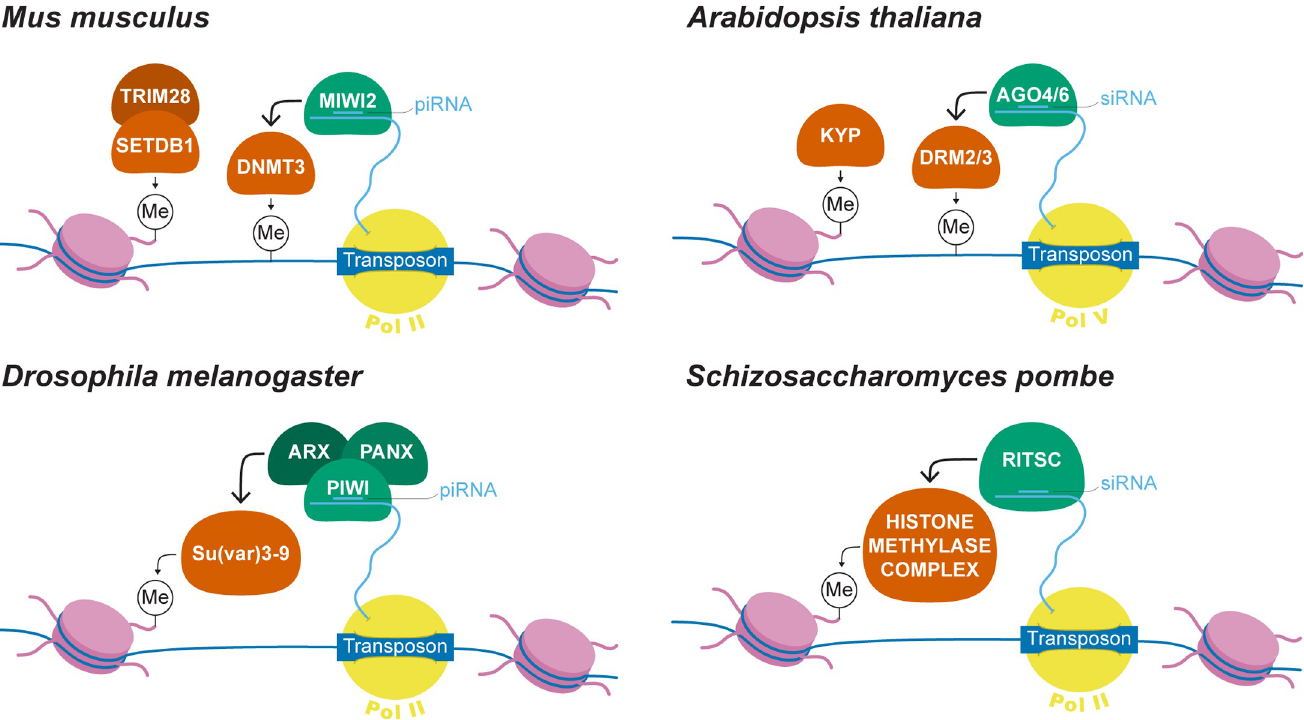
Fig 1. Mechanisms for the epigenetic silencing of TEs in animals and plants. To portray the similarities of the mechanism underlying TE epigenetic silencing between species, this figure only shows core proteins involved in the processes for four representative eukaryotic species. Detailed mechanisms and involved proteins could be found at other detailed reviews (e.g., [134,134–136]). In mammals, piRNAs are loaded onto MIWI2, which promotes a chromosomal environment that ultimately recruits the mammalian DNMT3 to methylate TE sequences [137,138]. Complementarily, KAP1, also called TRIM28, recognizes retroviral TE sequences by binding to a conserved primer binding site [139] and recruits H3K9 methyltransferase SETDB1 and HP1 to form a repressive heterochromatic environment at TE sequences [140–142]. Drosophila lacks DNA methylation, but TEs can still be epigenetically silenced through histone modifications. Nascent TE transcripts are targeted by piRNA loaded PIWI, which complexes with Asterix (Arx, also known as Gtsf1) and Panoramix (Panx, also called Silencio) [143–146]. This complex recruits Su(var)3-9, a key H3K9 methyltransferase, to lay down repressive H3K9me2/3 at TE sequences [147]. A similar mechanism is also observed in Schizosaccharomyces pombe, where RITSC binds to nascent TE transcripts through base-pairing with siRNAs and recruits histone methyltransferase complex to methylate H3K9 histone tails [148]. In plants, euchromatic TEs are silenced through the RdDM pathway [168]. AGO4 or AGO6 are guided by siRNA [149,150]and targeted to siRNA-matching regions through scaffolding RNA that were transcribed by Pol V [151–153]. This double-stranded RNA further recruits methyltransferases DRM1 and DRM2 (homolog to the mammalian methyltransferase DNMT3 [154]), resulting in methylation of TE sequences [155,156]. AGO4, argonaute 4; DNMT3, DNA methyltransferase 3; DRM,1, domains rearranged methylase 1; KAP1,; KRAB-associated protein 1 KRAB, Kru¨ppel-associated box; MIWI2, mouse piwi 2; pRNA, PWI-interacting RNA; RdDM, siRNA-directed DNA methylation; RITSC, RNA-induced transcriptional silencing complex; siRNA, small interfering RNA; TE, transposable